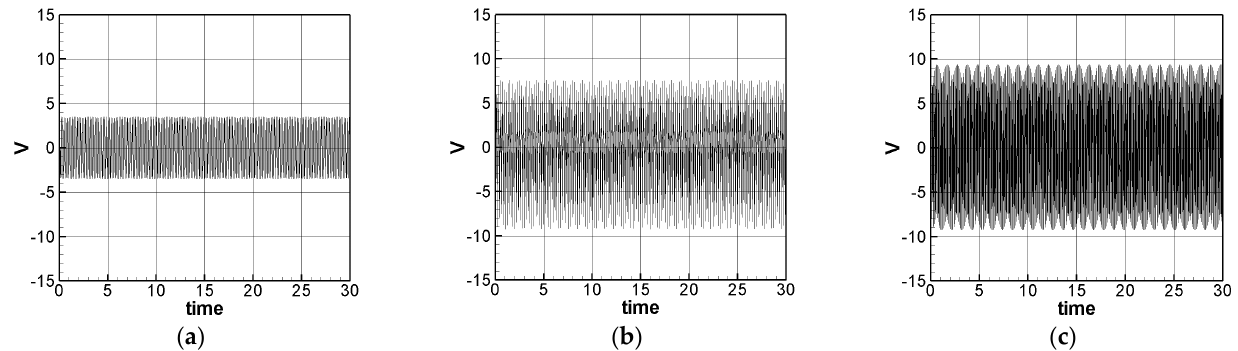
Figure 19. SES system theoretical voltage output (with dimension (volt)). ( a ) 1st mode, ( b ) 2nd mode, and ( c ) 3rd mode.